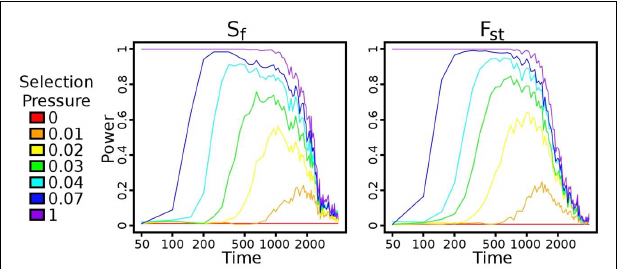
FIGURE 3 | Power versus time after bottleneck. Power is calculated using a 1% false positive rate, as described in Section 2.5. Once a haplotype gets fixed in the population, the power increases rapidly for both statistics, although with slightly more power using F st than using S f . As time continues, though, the signal decays faster in F st than in S f , largely because the controls vary more sharply as time